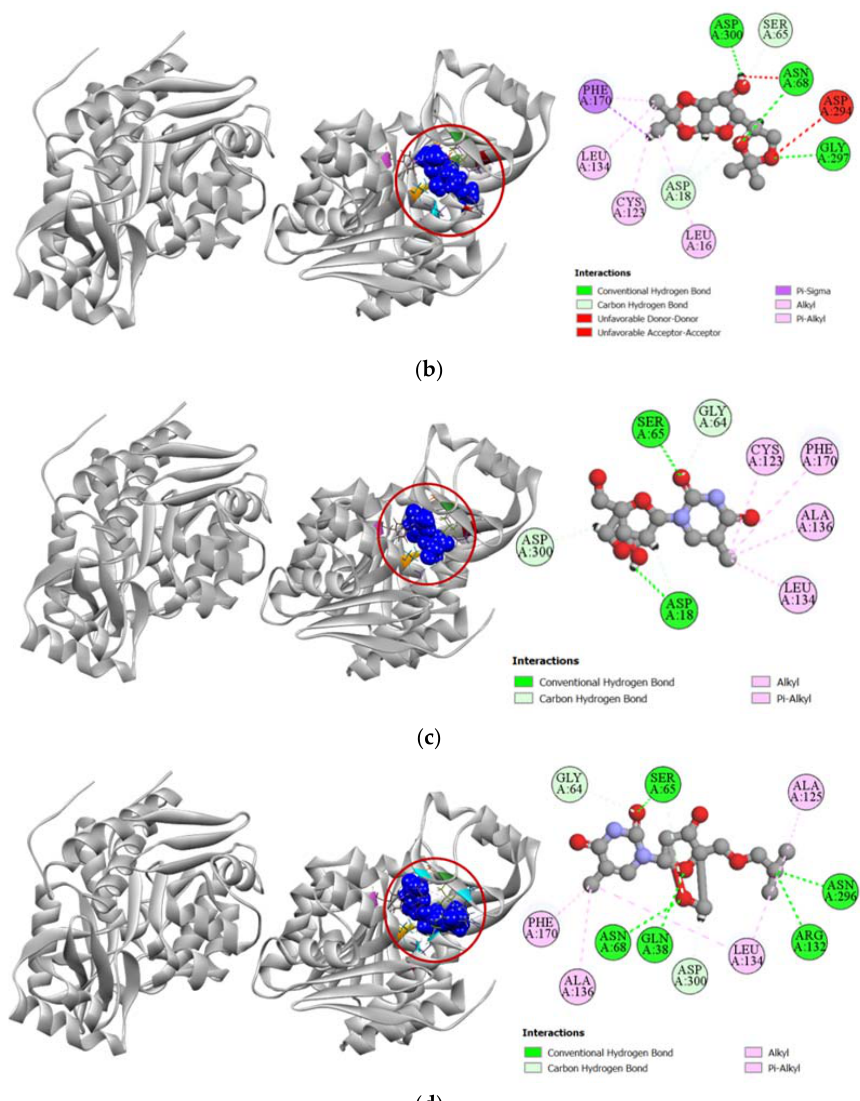
Figure 5. Pictorial representation (2D and 3D) of docking results for best-ranked pose of key inter- actions of ligands with the binding pocket of human adenosine kinase (PDB: 4O1L). ( a ) 5-ethynyl-7-(beta- D -ribofuranosyl)-7H-pyrrolo [2,3-d]pyrimidin-4-amine with 4O1L; ( b ) compound 2 with 4O1L; ( c ) compound 7 with 4O1L; ( d ) compound 8 with 4O1L.